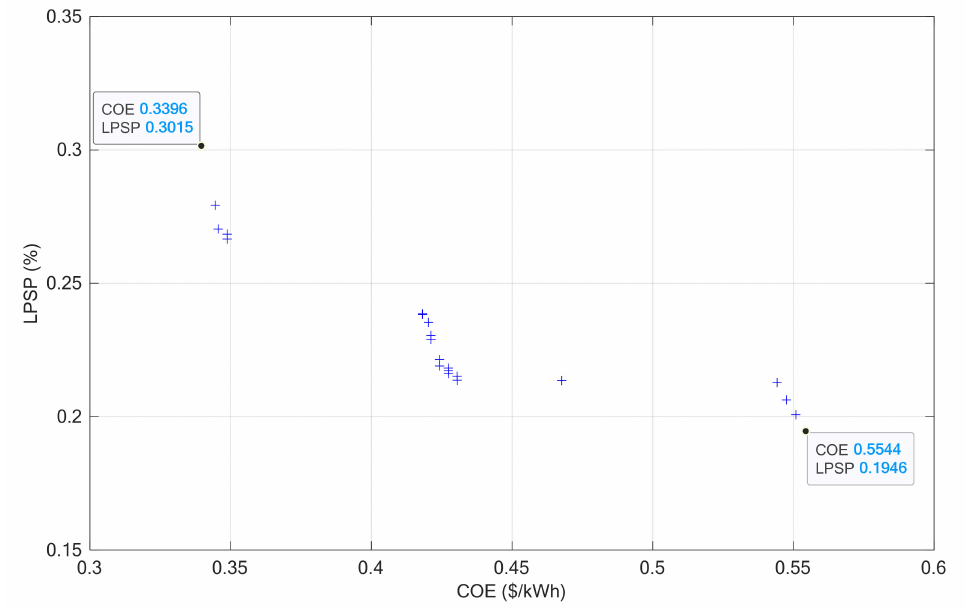
Figure 7. Pareto front (PF) obtained for CASE 1 using